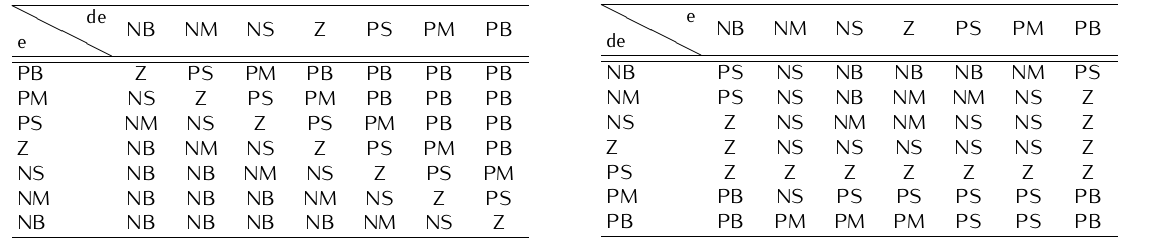
Table 3. The rule base for K